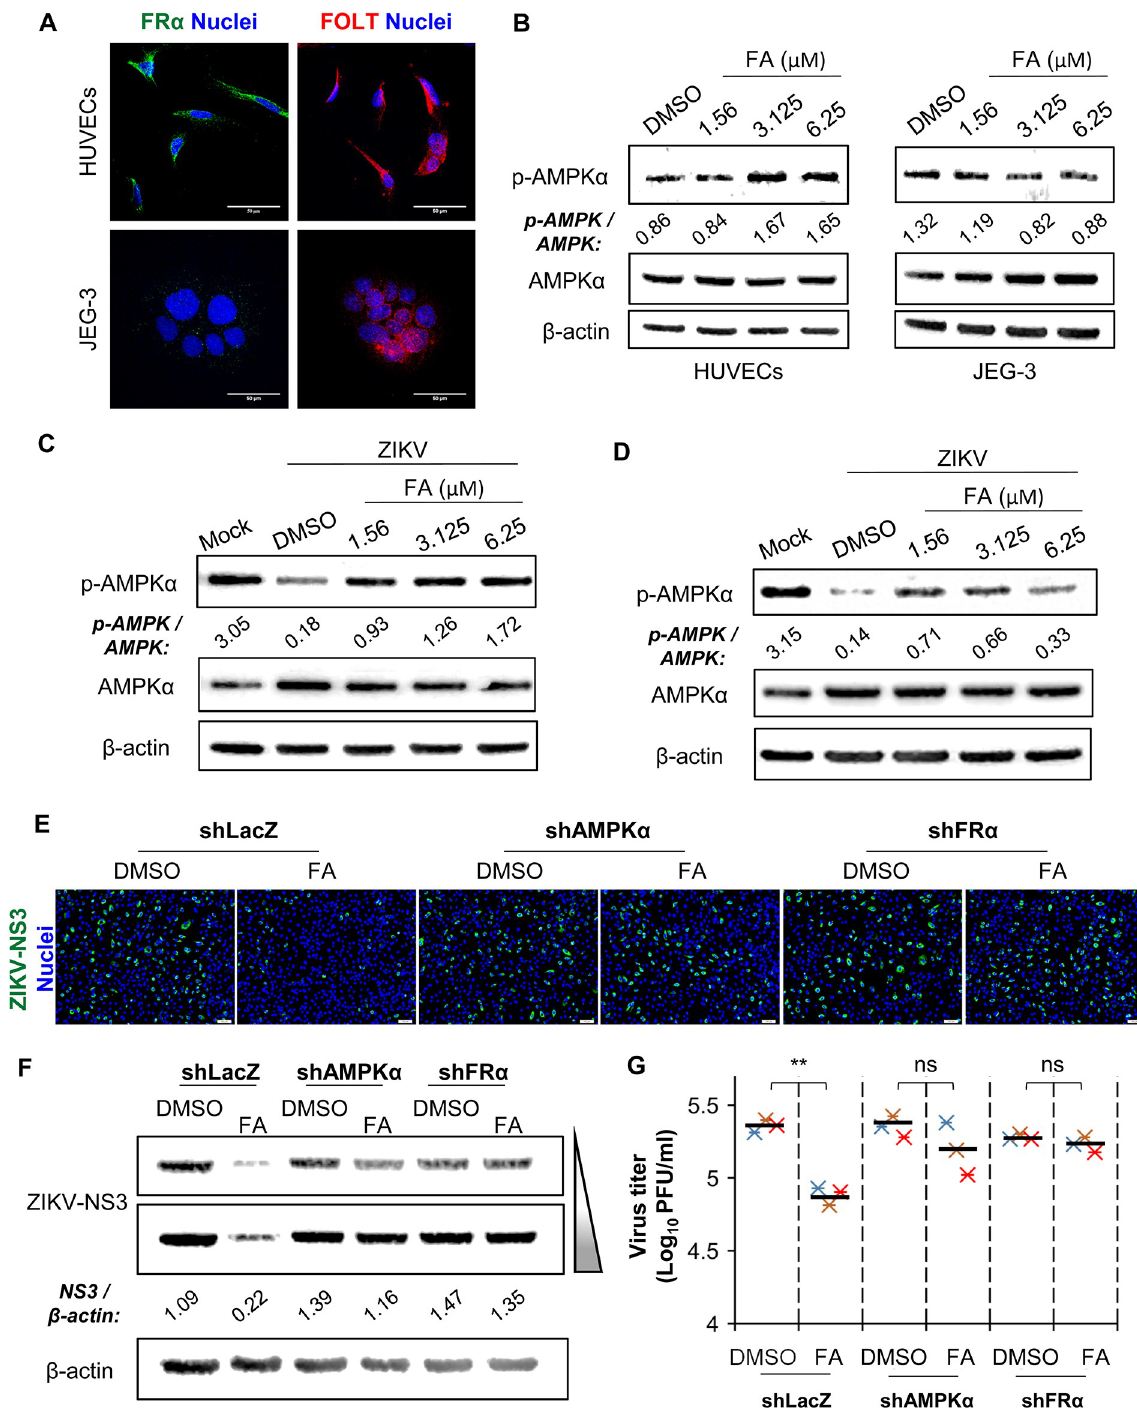
Fig 2. The antiviral effect of FA against ZIKV infection is associated with FR α -AMPK signal transduction. (A) Confocal images of HUVECs and JEG-3 cells immunostained for FR α (green), FOLT (red), and Hoechst for nuclei (blue). (B) Cells were treated with FA for 16 hr. Western blot analysis of the protein level of phospho-AMPK (p-AMPK), AMPK, and β -actin. Density ratios of p-AMPK and AMPK are shown in Western blot. (C-D) HUVECs (C) and JEG-3 cells (D) were treated with FA for 16 hr. Cells were infected with ZIKV in the presence of FA for 24 hr. Western blot analysis of the protein level of phospho-AMPK (p-AMPK), AMPK, and β -actin. Density ratios of p-AMPK and AMPK are shown in Western blot. (E-G) HUVECs were transfected with shRNA-targeting FR α (shFR α , TRCN0000372330), AMPK α (shAMPK α , TRCN0000000859), or control shRNA (shLacZ, TRCN0000072223) for 48 hr. Cells were treated with FA for 16 hr. Cells were infected with